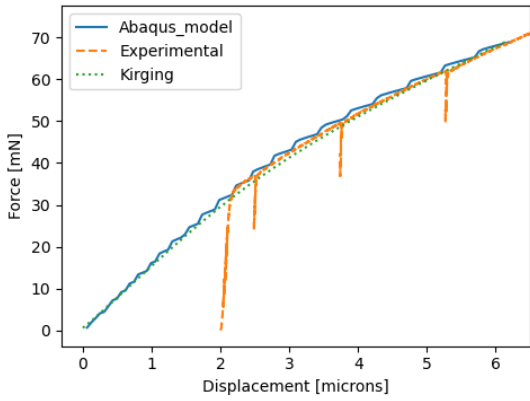
Fig. 2. Force-displacement curves. blue line: Abaqus model; orange line: experimental data; green dotted line: kriging